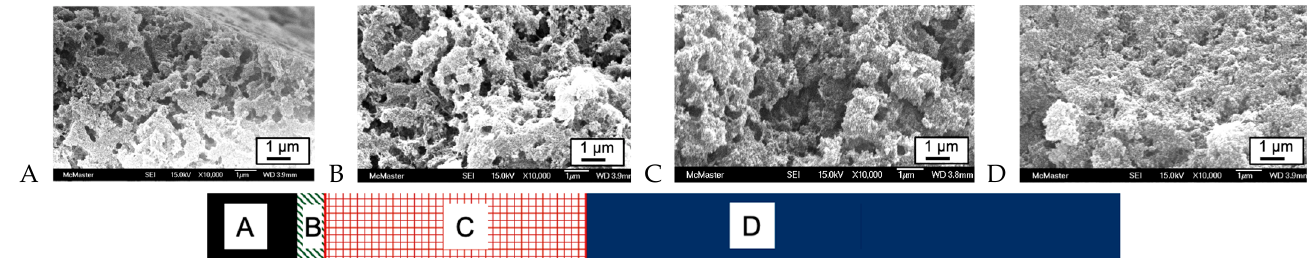
Figure 4. Cross-section of a starch/silica sample after enzymatic digestion; the largest changes were observed in domain C. The sample was ~16 mm 2 × 2.2 mm thick. SEMs were taken at depths of ( A ) 5 µ m; ( B ) 275 µ m; ( C ) 650 µ m; ( D ) 1.1 mm. All SEMs were measured at 10,000 × and the scale bar shows 1